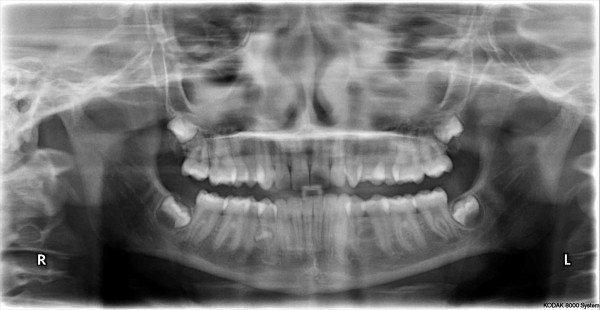
Orthopantomography. Image shows a bilateral opacity of the maxillary sinuses.